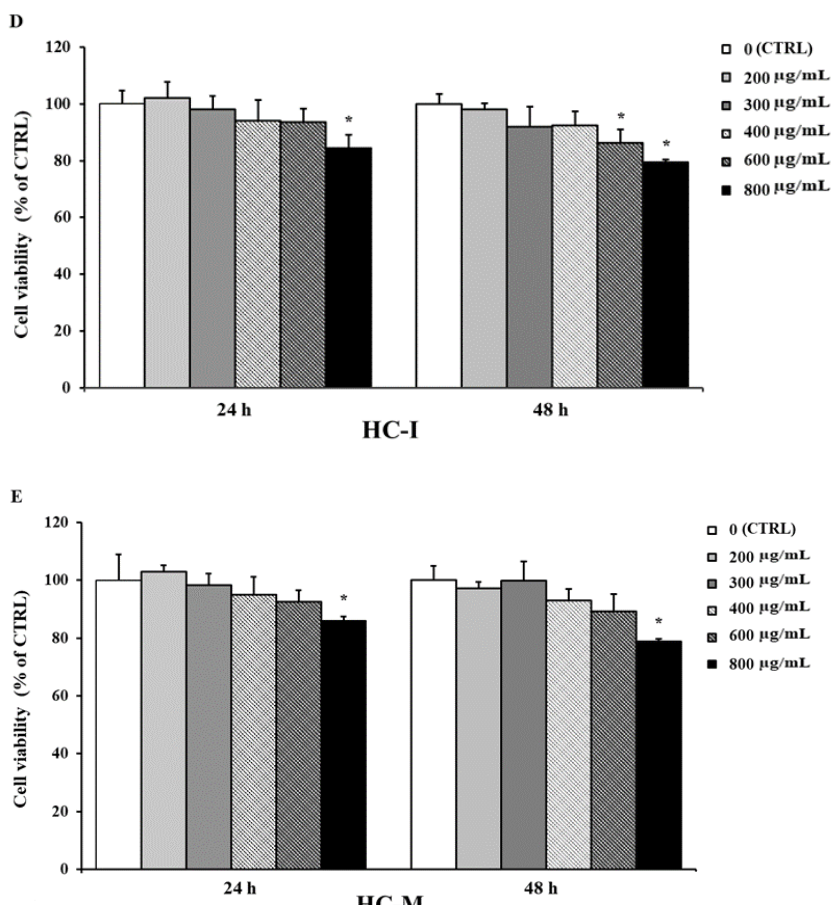
Figure 2. Viability of HepG2 cells treated for 24 and 48 h with different concentrations of ( A ) HC-R/BuOH, ( B ) HC-MeOH, ( C ) HC-D, ( D ) HC-I, ( E ) HC-M. Data are expressed as the mean ± SE of three independent experiments (n = 3) and were analyzed by one-way ANOVA followed by Dunnett’s post-hoc test, * p < 0.05, ** p < 0.01 and *** p < 0.001 vs. CTRL (100% viability).